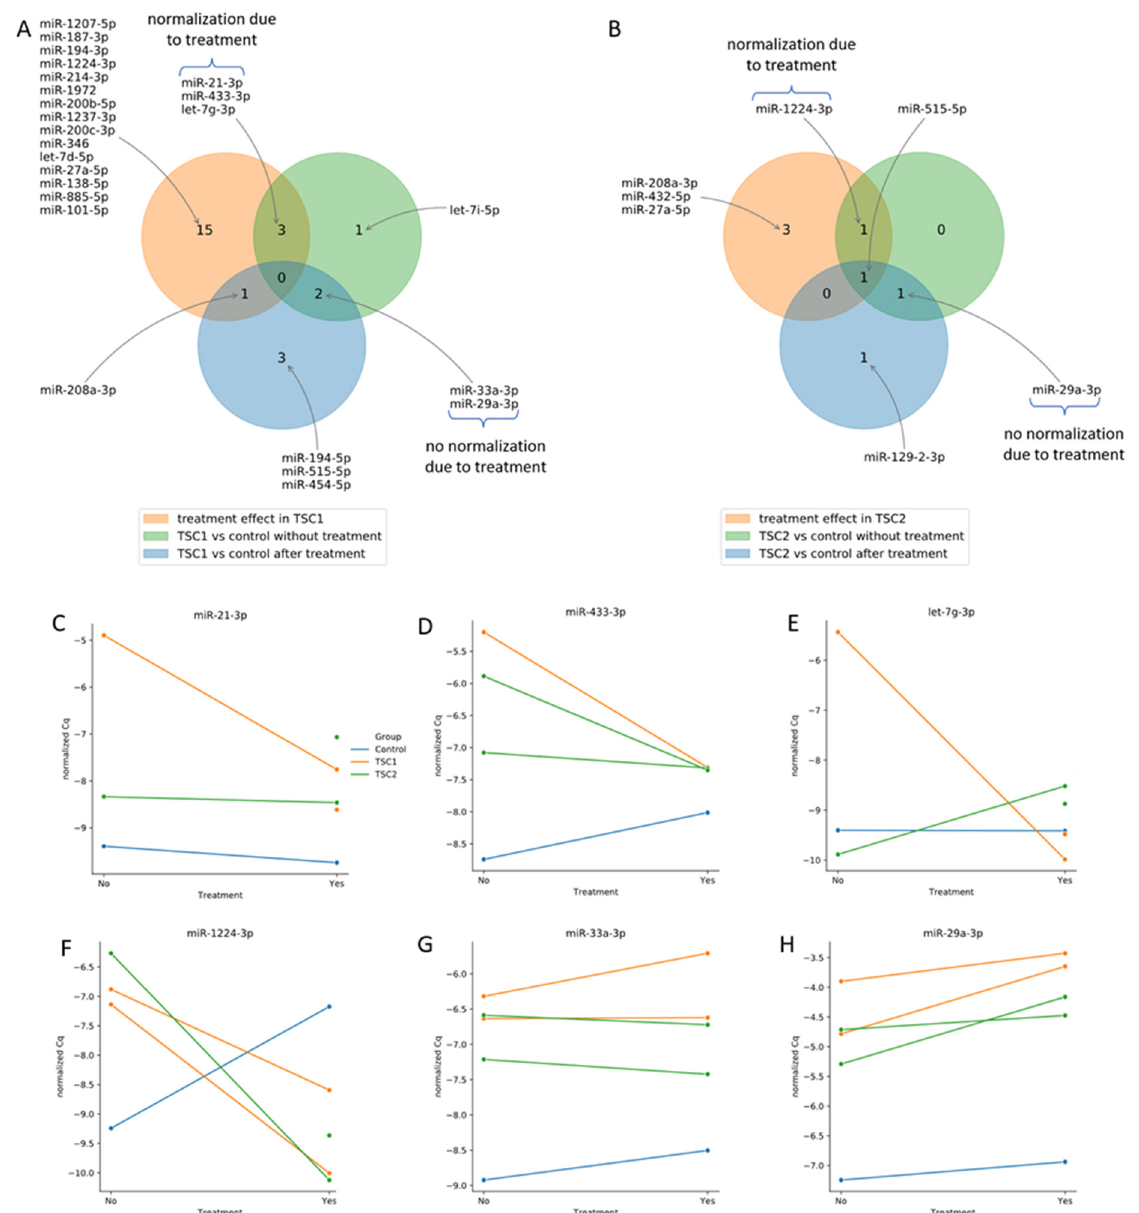
Figure 3. Effect of rapamycin treatment in TSC1 ( A ) and TSC2 ( B ) defects on miRnome. Expression of miRNAs that normalized after rapamycin treatment: miR-21-3p ( C ), miR-433-3p ( D ), let-7g-3p ( E ), miR-1224-3p ( F ) and those that did not normalize: miR-33a-3p ( G ) and miR-29a-3p ( H ). To evaluate the implications of the miRNAs which did not normalize after treatment, the experimentally validated targets from miRTarBase were analyzed using miRWalk software (http://mirwalk.umm.uni-heidelberg.de/, accessed on 21 October 2022). In total, 51 genes were found; however, none of them were targeted by both miR-33a-3p and miR- 29a-3p (Figure 4, Supplementary File 12), and no Reactome or KEGG pathways involving the two miRNAs were identified (Supplementary Files 14 and 15). Subsequent analysis revealed putative targets (predictions from miRDB generated by MirTarget) for the selected miRNAs (Supplementary File